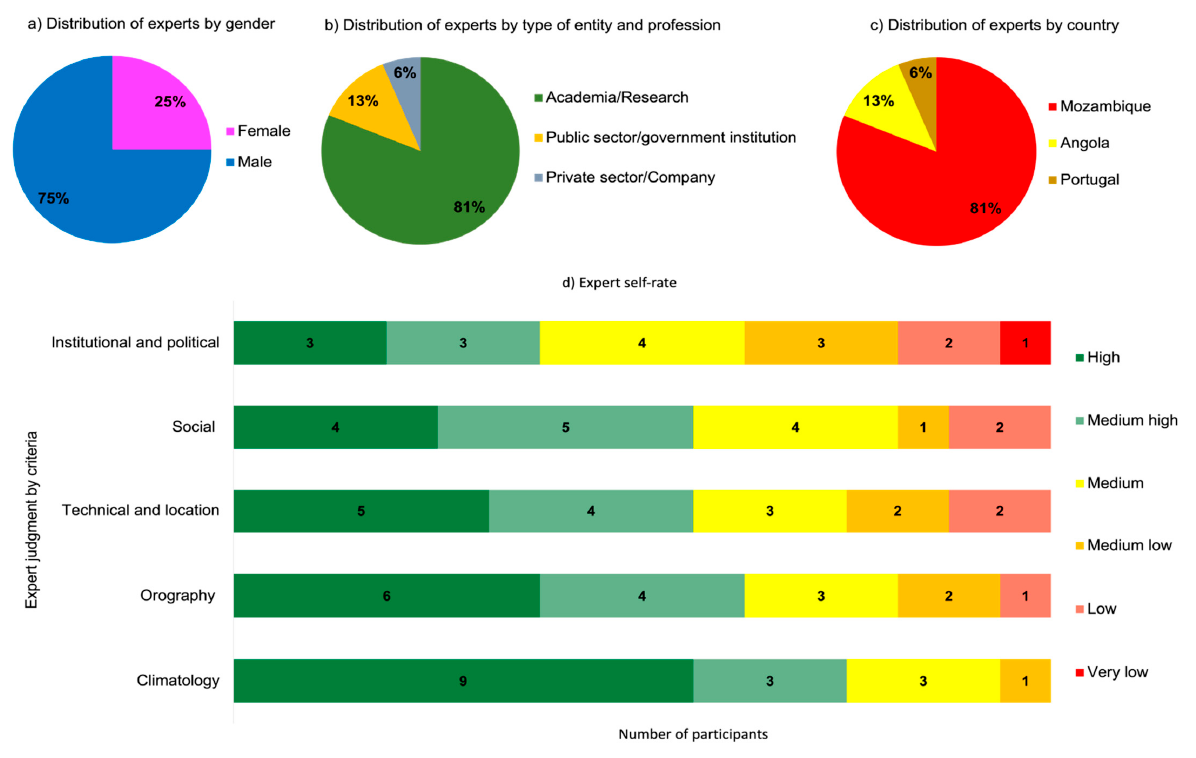
Figure 8. The main characteristics of experts and criteria judgment.